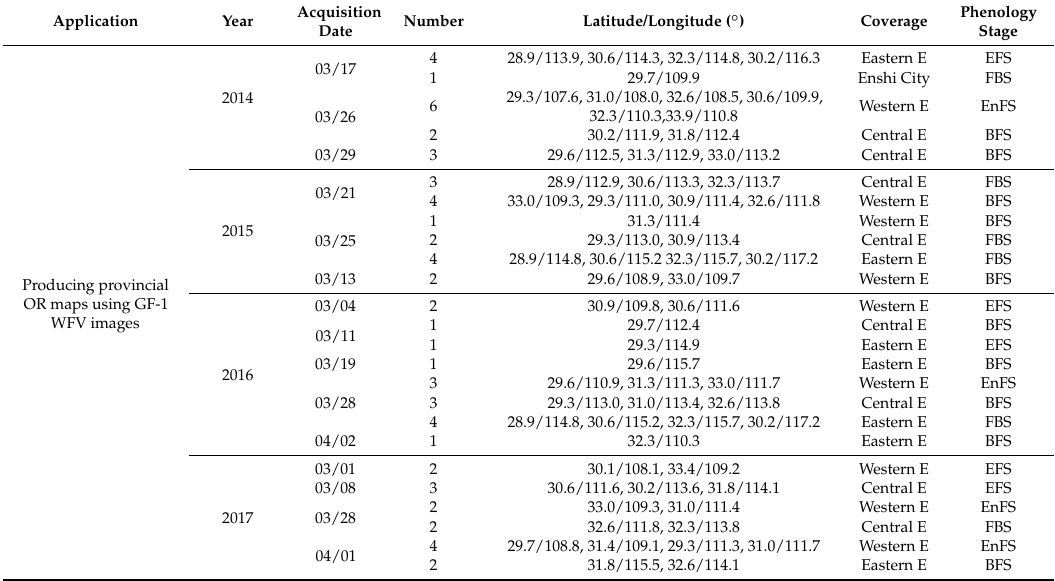
Table A1. The information of GF-1 WFV images used to produce OR maps of Hubei